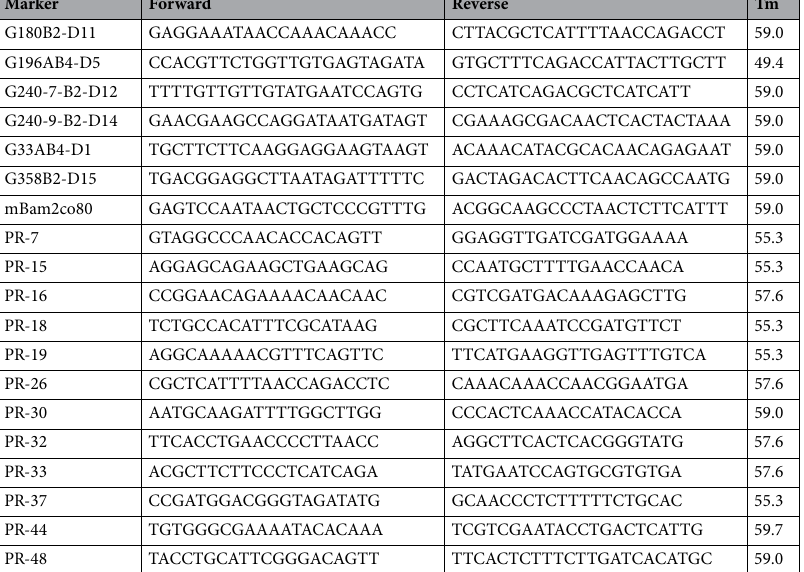
Table 2. Primer Sequence information and annealing temperature for the 19 Bambara specific SSR markers.